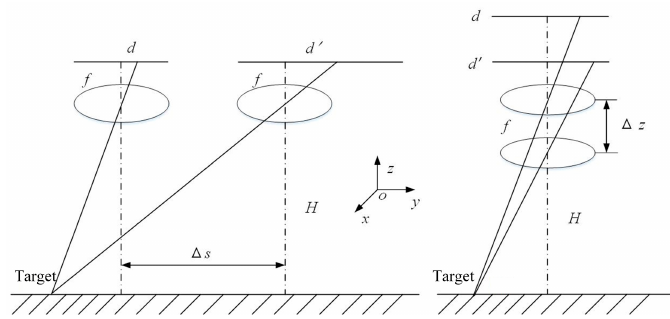
Figure 4. Pixel movement caused by translation.